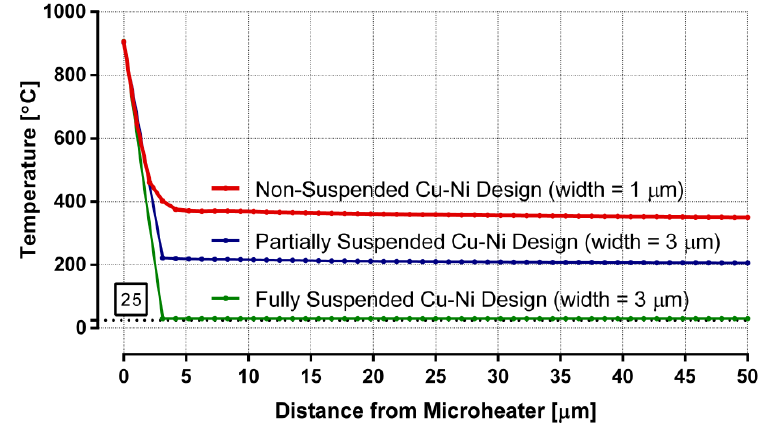
Figure 8. Temperature distribution from the center of different cupronickel microheaters to the surrounding surface.